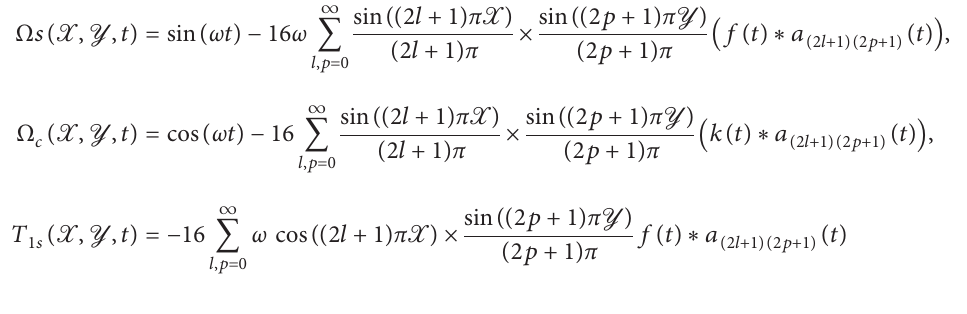
Figure 3: The variation of β for both the oscillations with ω � π /4, λ